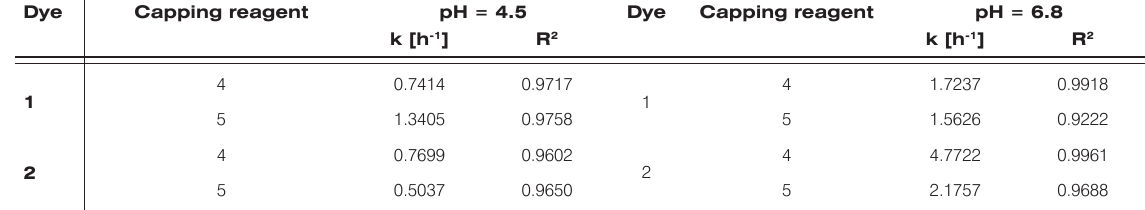
Table 4. Fitting parameters of release experiments carried out with a first order release model, described by the equation f(t) = 1 – e -kt . Dye